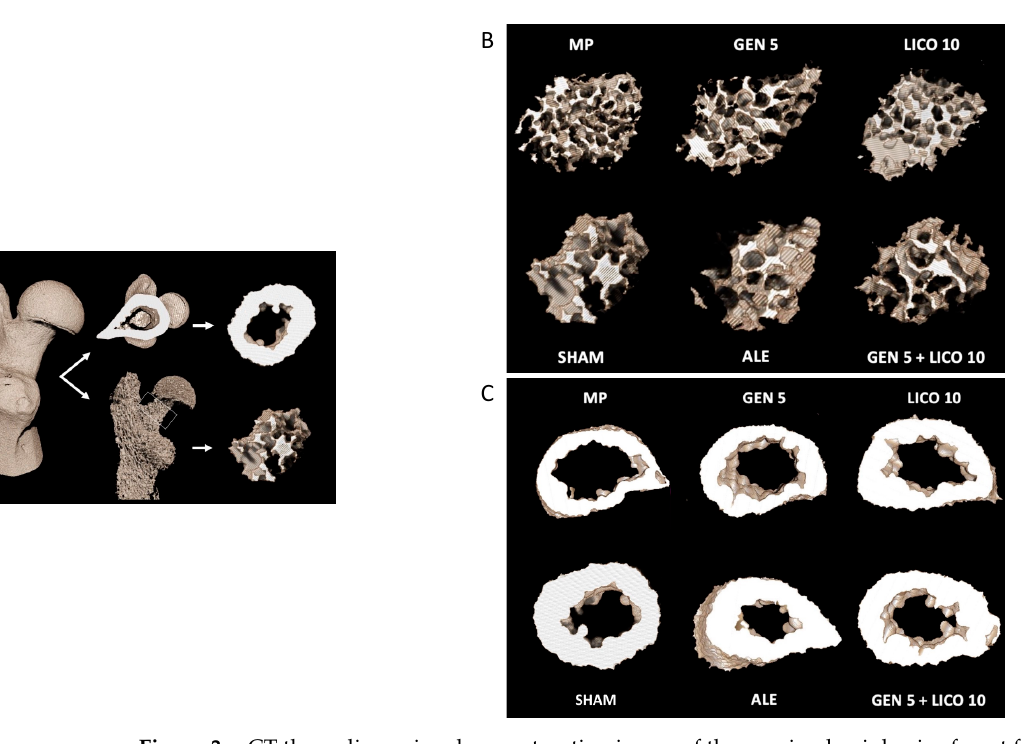
Figure 3. µ CT three-dimensional reconstruction image of the proximal epiphysis of a rat femur. The scheme shows how images were post-processed in order to separate trabecular and cortical volumes, prior to proceeding with the femoral neck morphometric analysis and BMD assessment ( A ). µ CT three-dimensional images of the trabecular ( B ) and cortical ( C ) bone microarchitecture of the femoral neck. ( A ) Trabecular thickness is increased in the ALE and GEN LICO group, compared to the MP vehicle. Similarly, there is a rods-to-plates transition in the same groups, compared to the vehicle. ( B ) Cortical thickness and bone fraction are consensually increased in ALE and GEN LICO groups compared to MP vehicles.